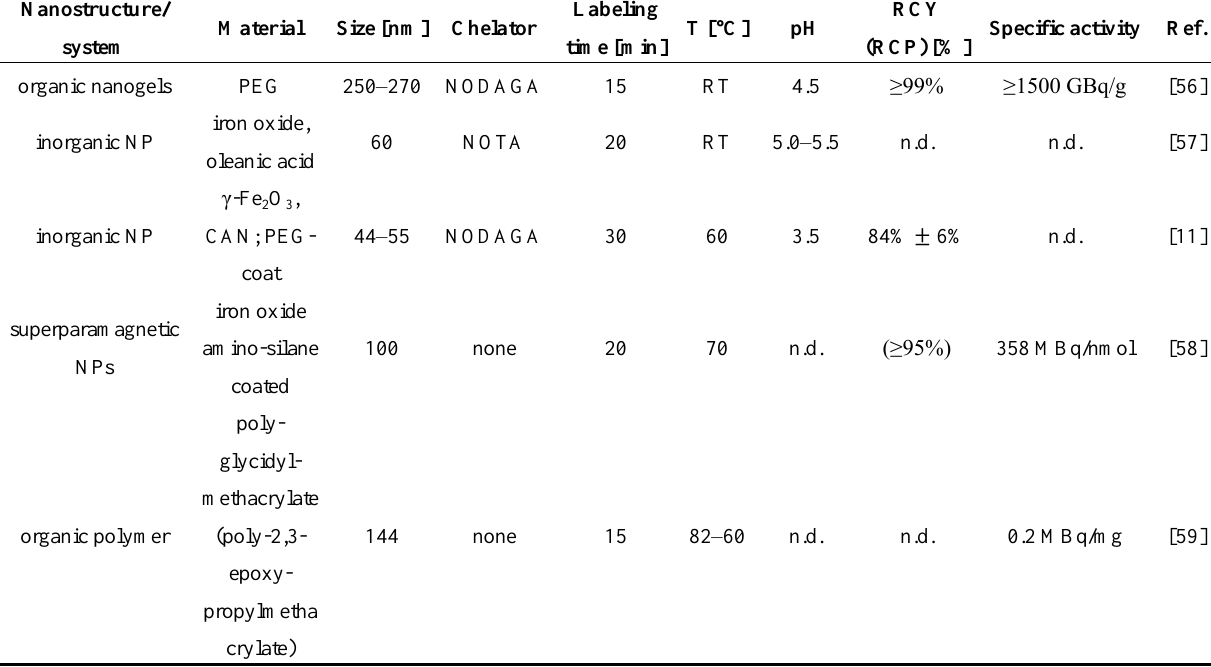
Table 3. An overview of the different approaches of 68 Ga-labeled nanoparticles and polymers and crucial parameters. (n.d. = no data, RCY = radiochemical yield, RCP = radiochemical purity, CAN =